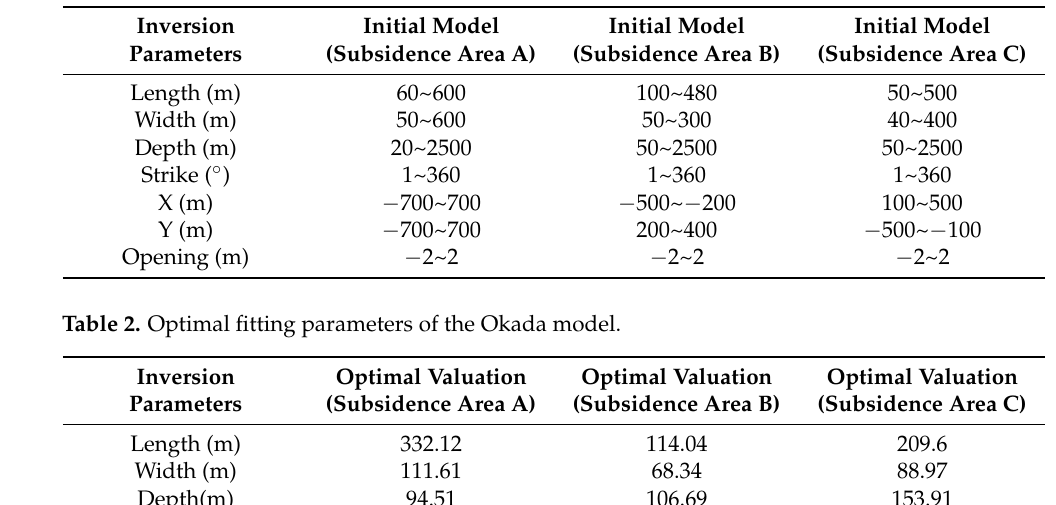
Table 1. Original inversion parameters of the Okada model.